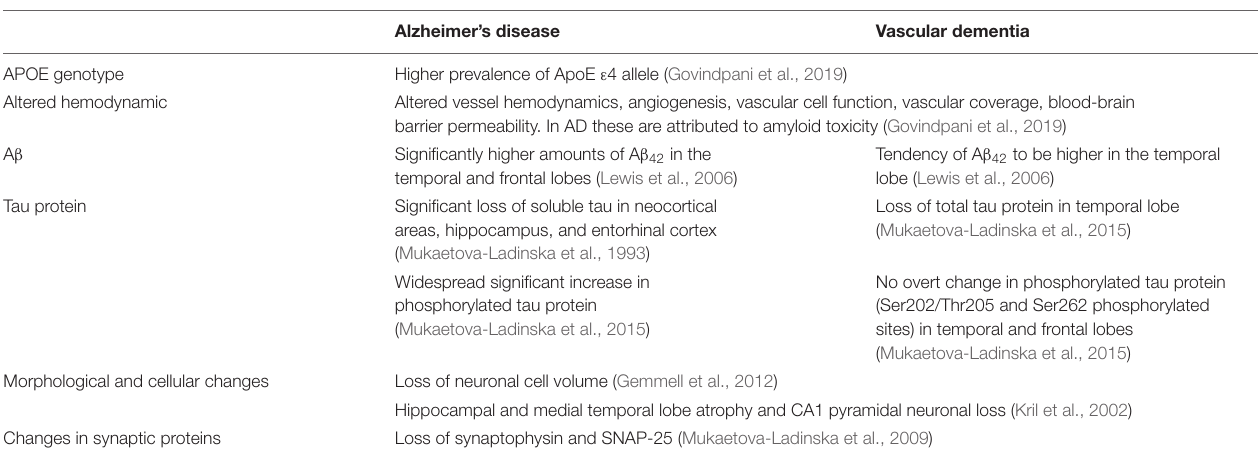
TABLE 1 | Pathophysiological similarities between AD and